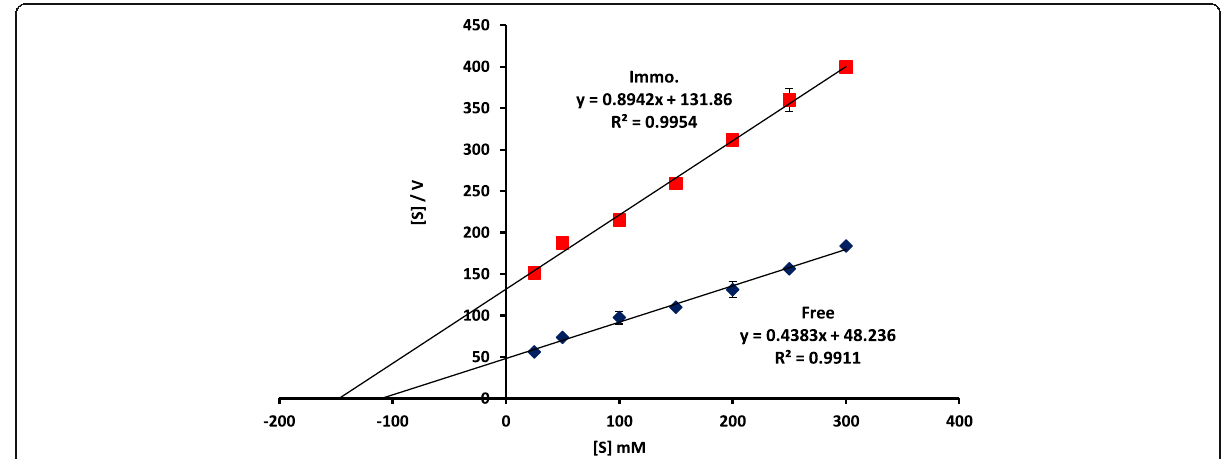
Fig. 9 Kinetic parameters of free and immobilized glucoamylase enzyme using the Hanes-Woolf plot